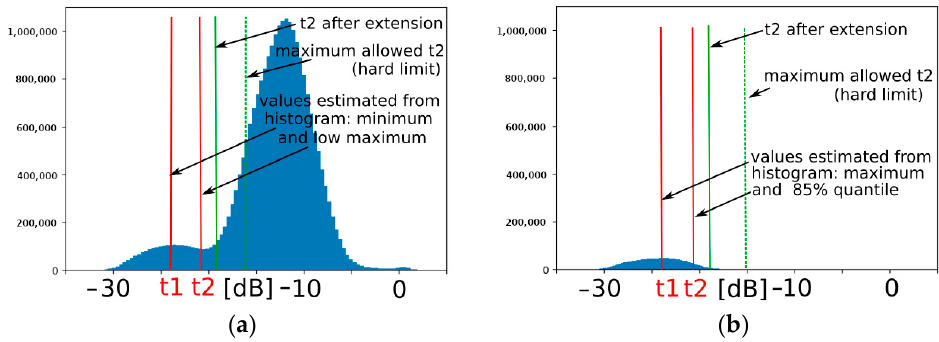
Figure 4. Water–land threshold estimation and adaptation for the bimodal histogram method ( a ) and the open-water histogram method ( b ). The red lines indicate the thresholds t 1 , t 2 , estimated from the histogram, while the solid green line indicates the extended t 2 threshold. The dashed green line indicates the maximum allowed threshold t 2 (hard limit).